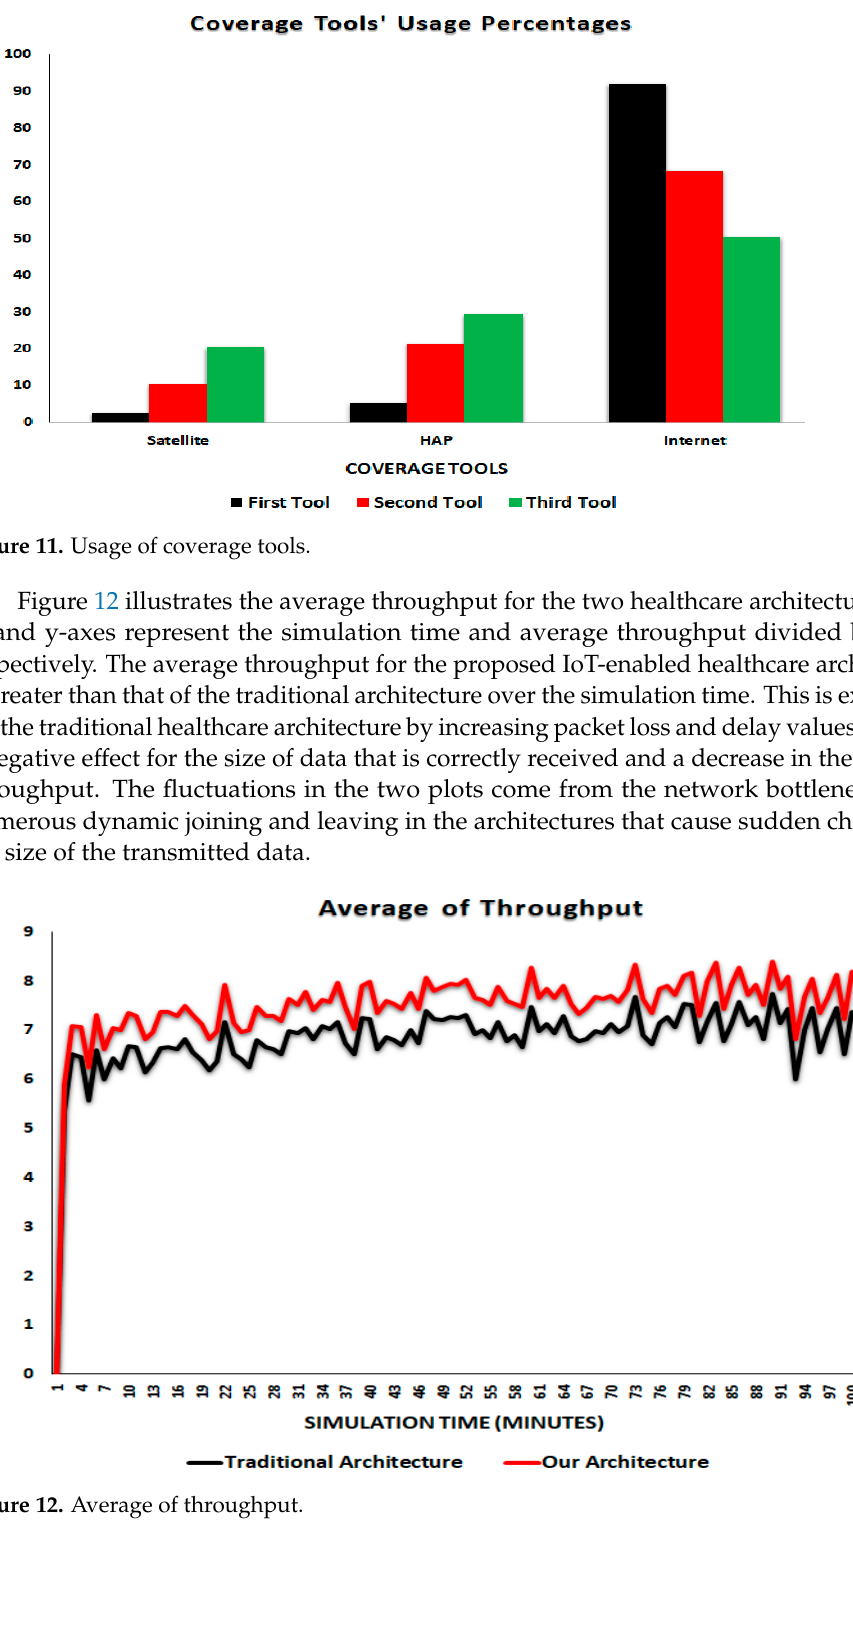
Figure 12. Average of